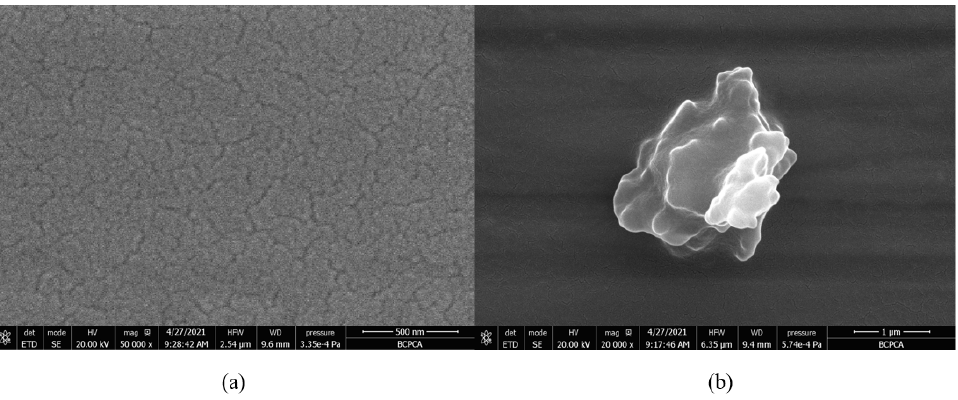
Figure 2. SEM micrographs of TPZBF-7 ( a ) and TPZBF-9 ( b ).